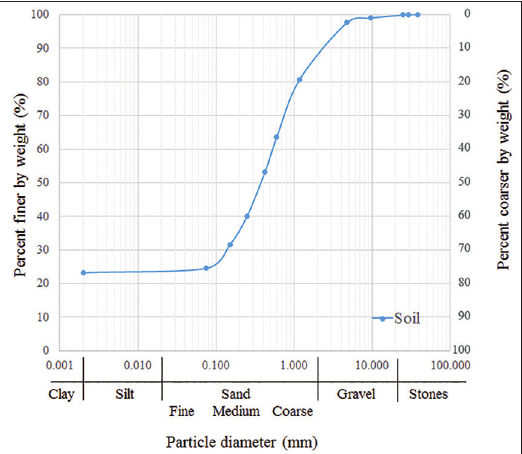
Figure 3: Granulometric structure of the